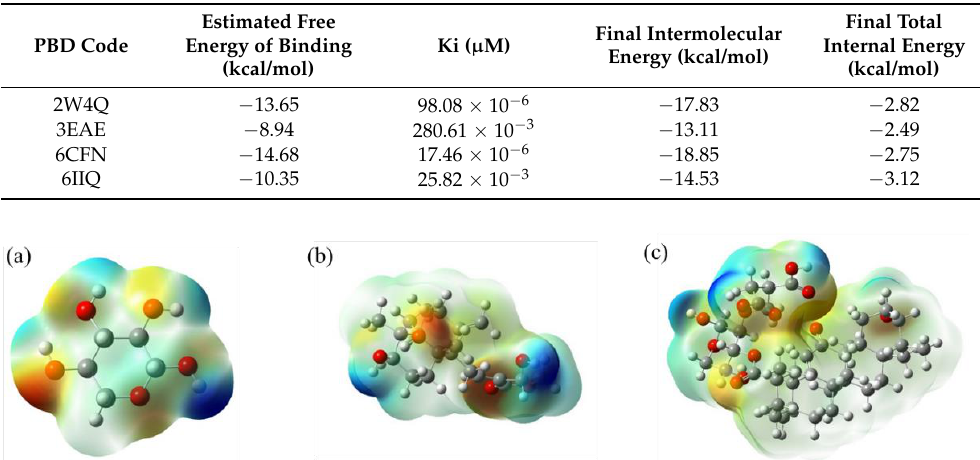
Figure 10. Electrostatic potential distribution of BX ( a ), AD ( b ) and GA-BX/AD-g-IA ( c ). Table 2. The dock evaluation of receptor protein with GA-BX/AD-g-IA.